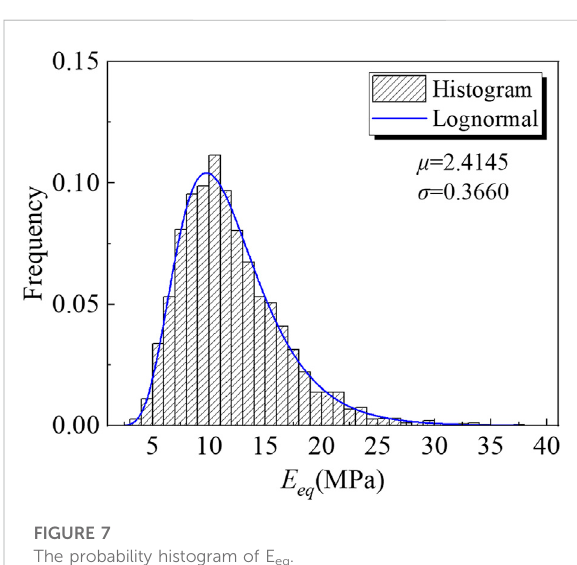
FIGURE 7 The probability histogram of E eq